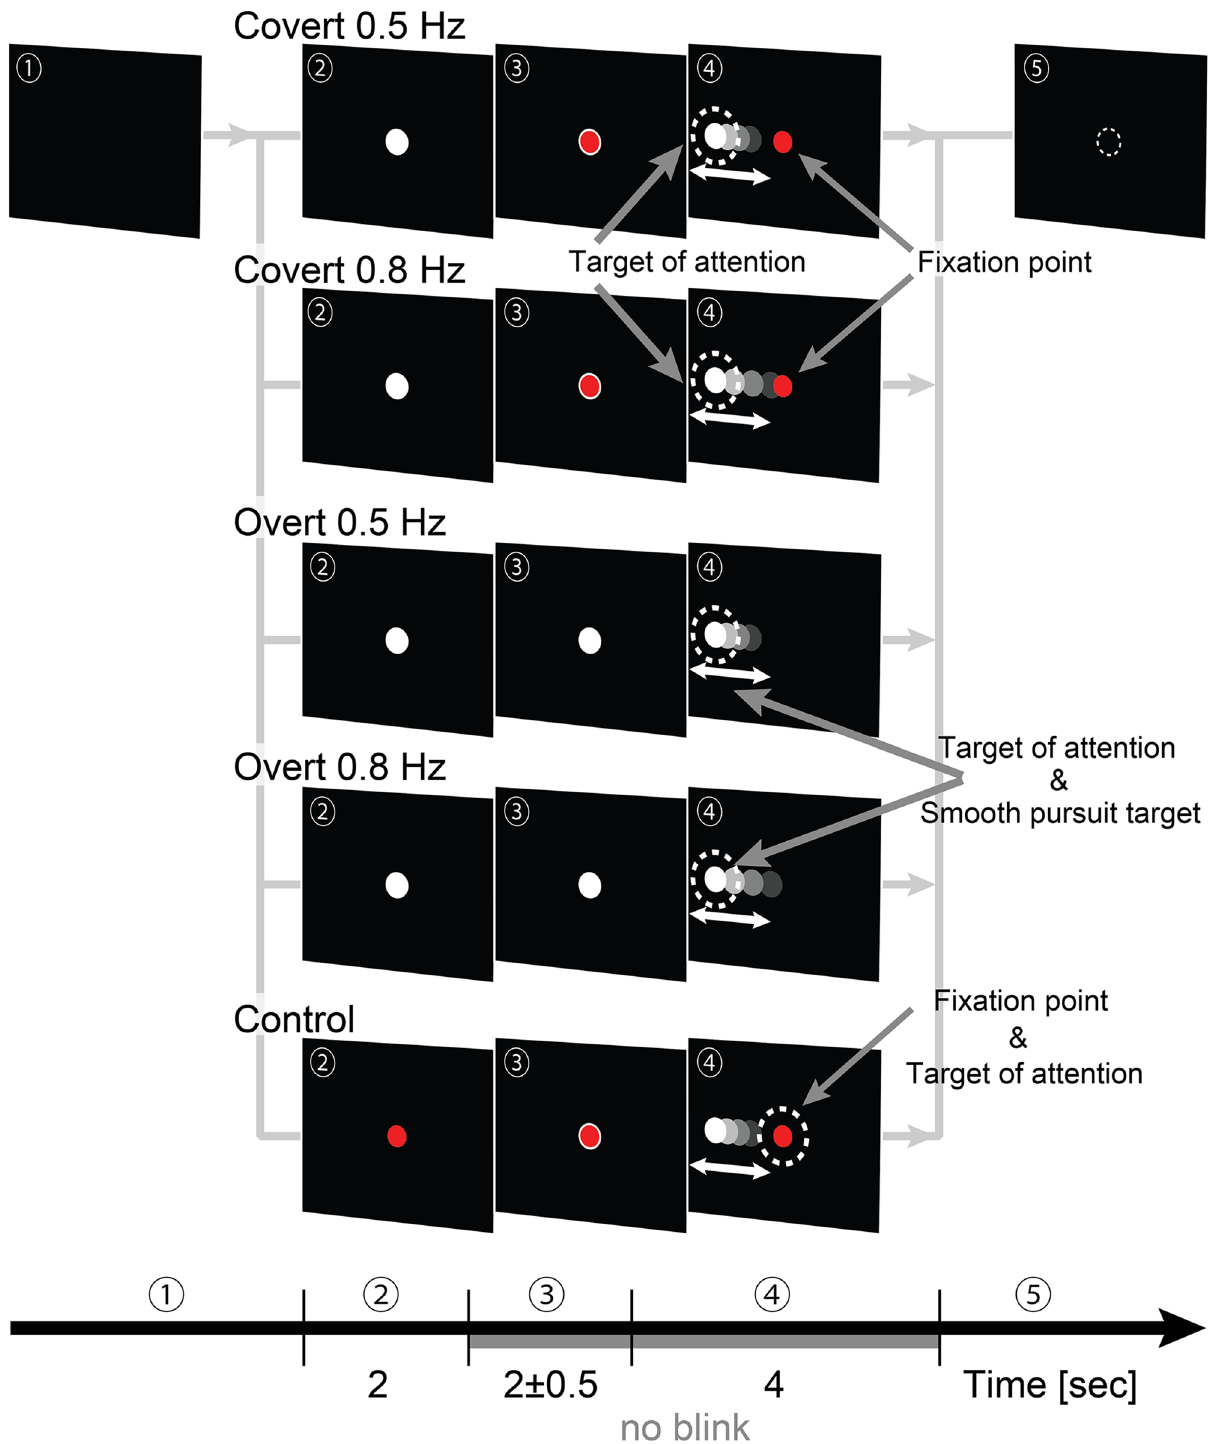
Figure 1. Experimental protocol. Target motions were sinusoidal. Their frequencies were 0.5 or 0.8 Hz, and their peak velocities were 20°/s. Peak amplitudes of 0.5 and 0.8 Hz target motions were 6.37° and 3.98°, respectively. Diameters of white and red-filled targets were 0.44° and 0.35°,